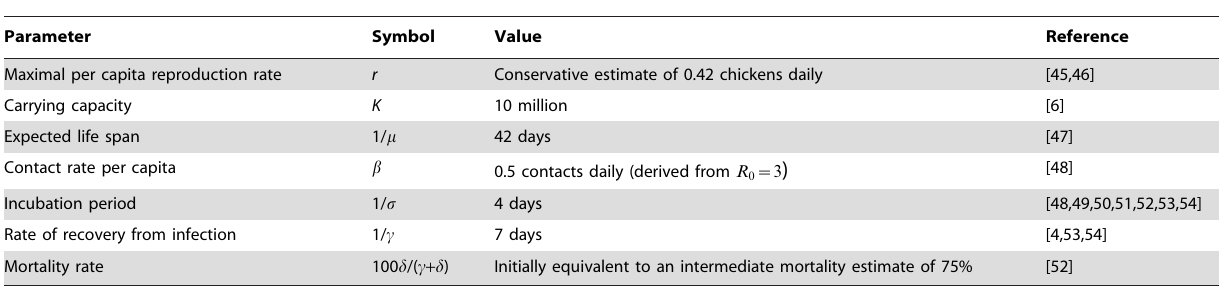
Parameter Symbol Value Maximal per capita reproduction rate r Conservative estimate of 0.42 chickens